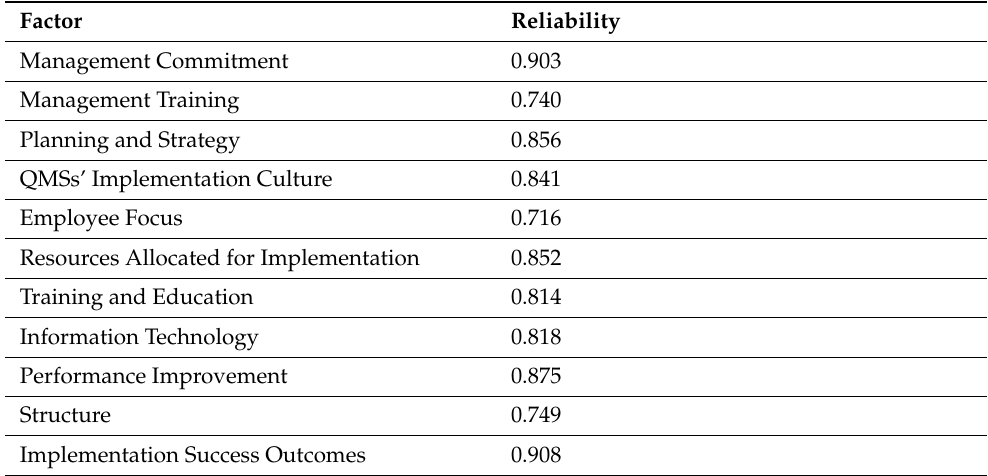
Table 5. Emergent factors’